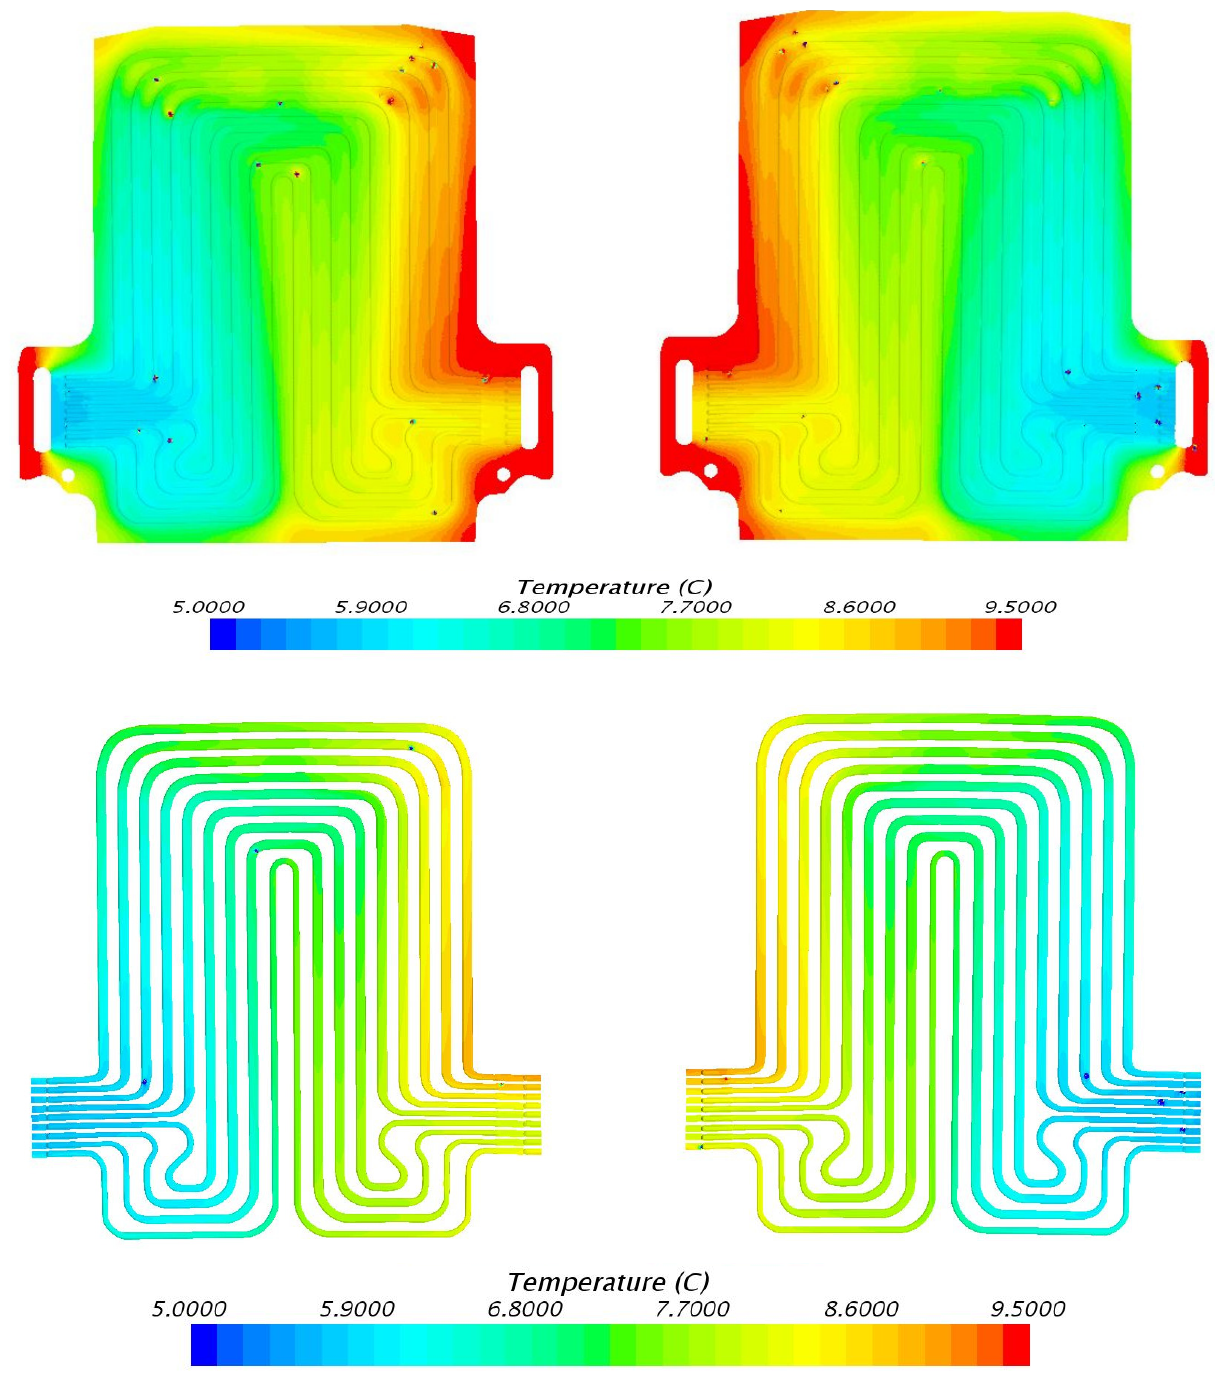
Figure 11. Temperature field at 40 A discharge current and 5 °C coolant inlet temperature, with heat flux at position 1 = 1294.5 W/m 2 , position 2 = 1390.8 W/m 2 , and position 3 = 341.3 W/m 2 .